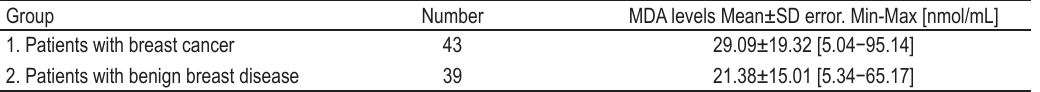
TABLE 1. MDA serum levels in patients with breast cancer and with benign breast disease Group